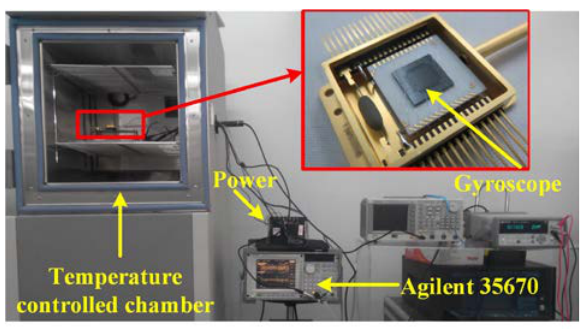
Figure 11. Test system of the gyroscope.